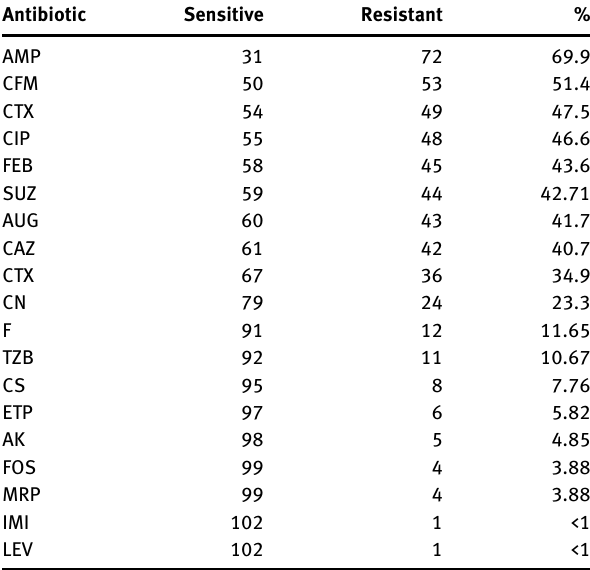
Table  : The resistance of E. coli isolated from patients to